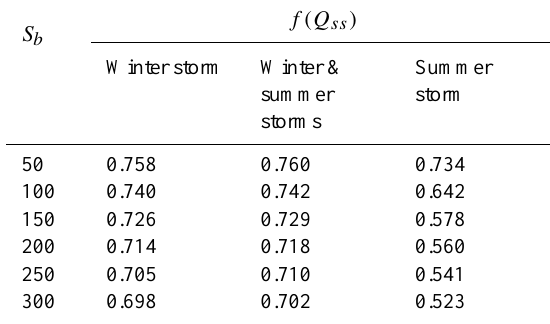
Table 3b. The frequency of occurrence for subsurface